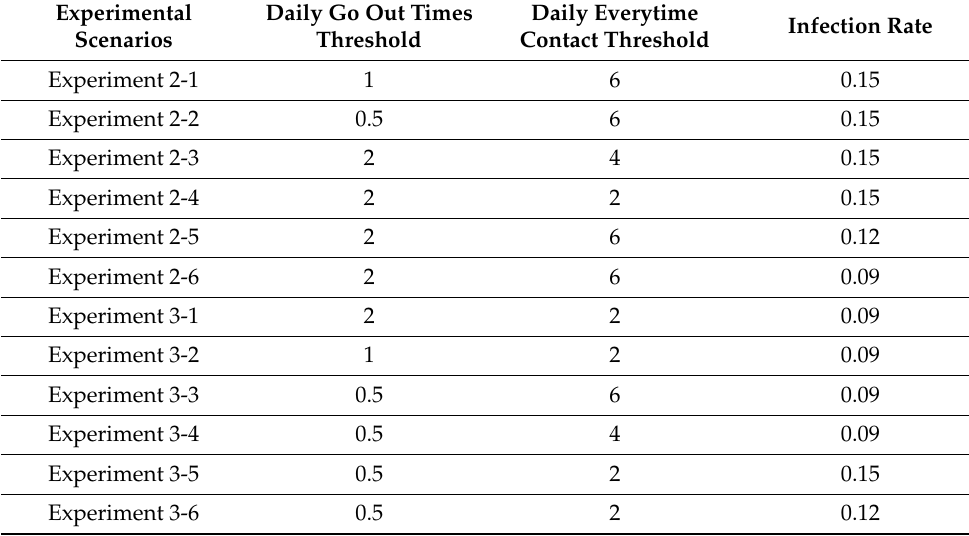
Table 3. Variation experiments based on three kinds of going-out needs. Experimental Daily Go Out Times Daily Everytime Scenarios Threshold